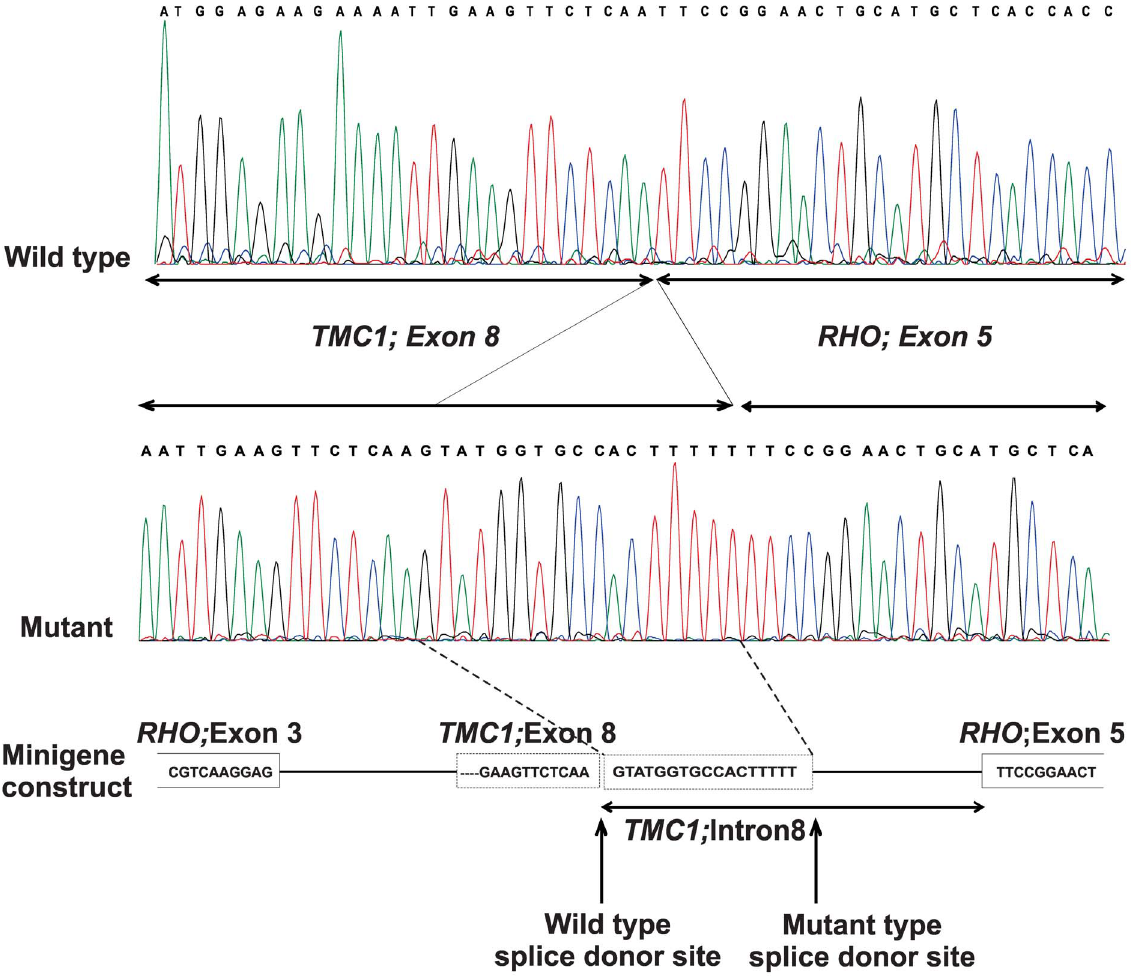
Figure 3. Effect of TMC1 intronic mutation c.362 + 18A . G using a minigene approach. Electropherogram of the partial cDNA sequence of RNA derived from cells transfected with the pCI-NEO with either the mutant or wildtype TMC1 exon 8. The mutation leads to the insertion of 17bp at the 3 9 end of exon 8, which can be predicted to result in a premature stop codon in exon 9 (p.Glu122Tyrfs*10).